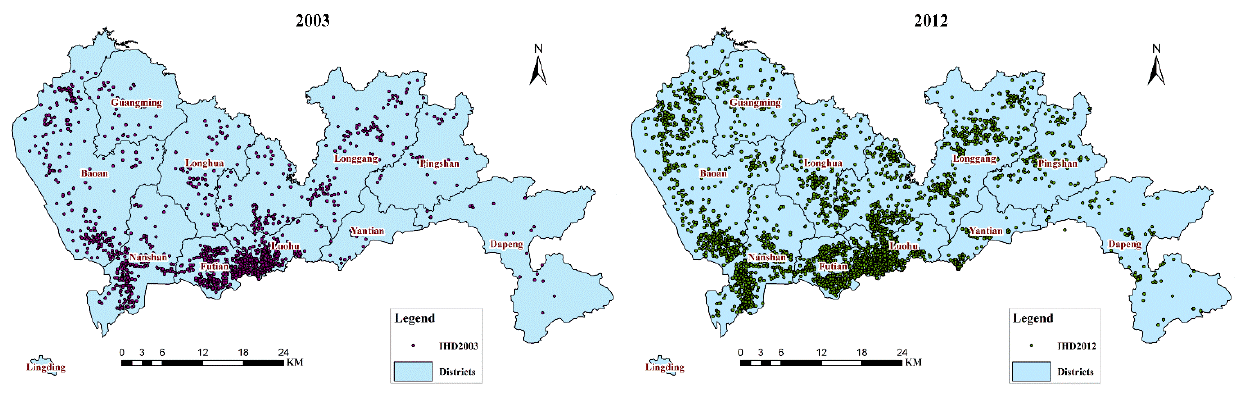
Figure 2. Distribution map of annual IHD hospitalizations, with 2003 and 2012 as examples.